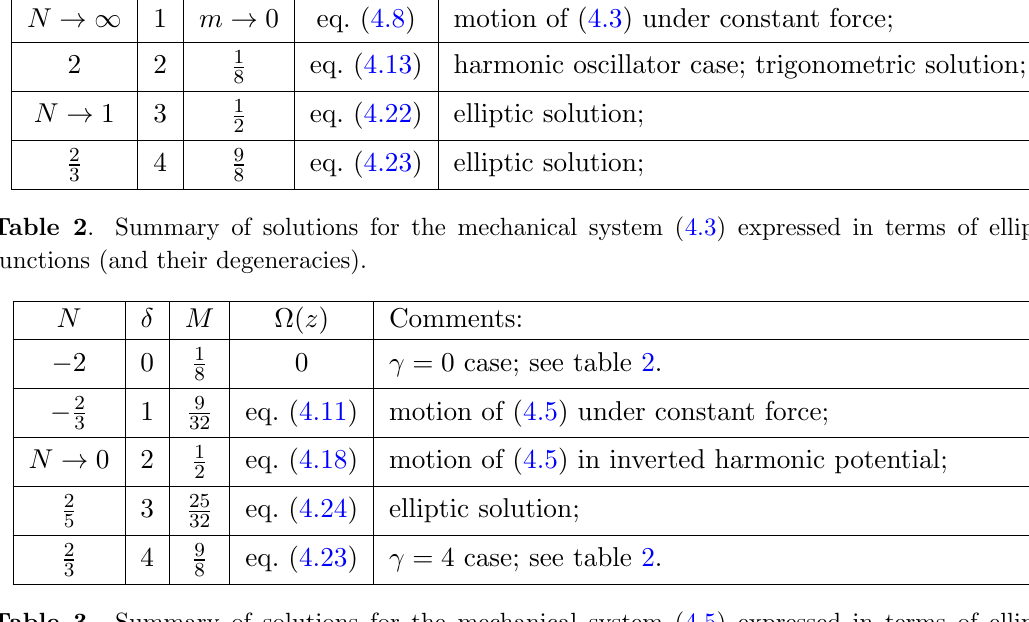
Table 3 . Summary of solutions for the mechanical system (4.5) expressed in terms of elliptic functions (and their